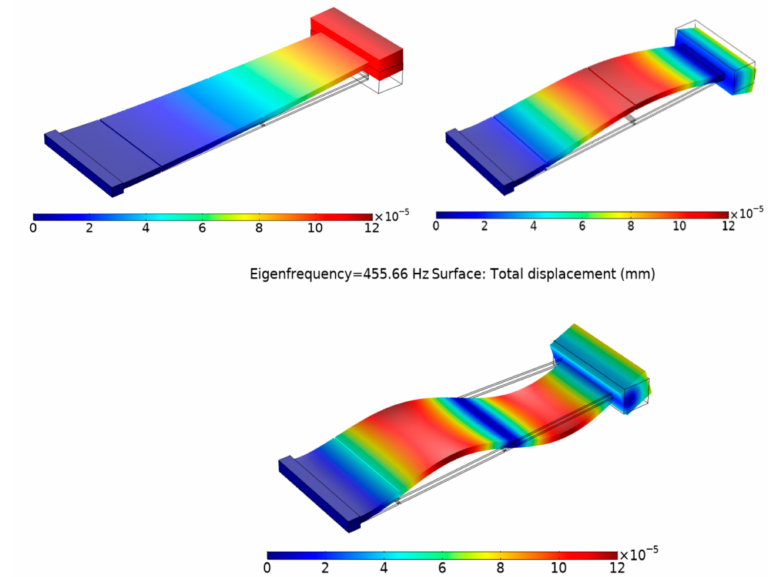
Figure 4. First three vibration modes of the cantilever-based bimorph segmented PVEH with a tapering ratio of 0.7.